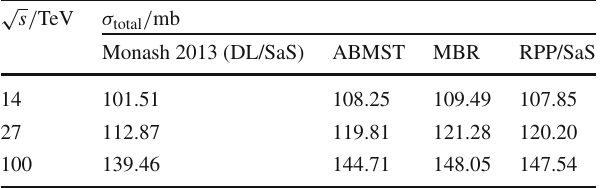
√ s Table 7 Table showing the NLO inclusive jet cross section for (a) p ⊥ j ≥ 50 GeV and (b) p ⊥ j ≥ 100 GeV,as predicted by